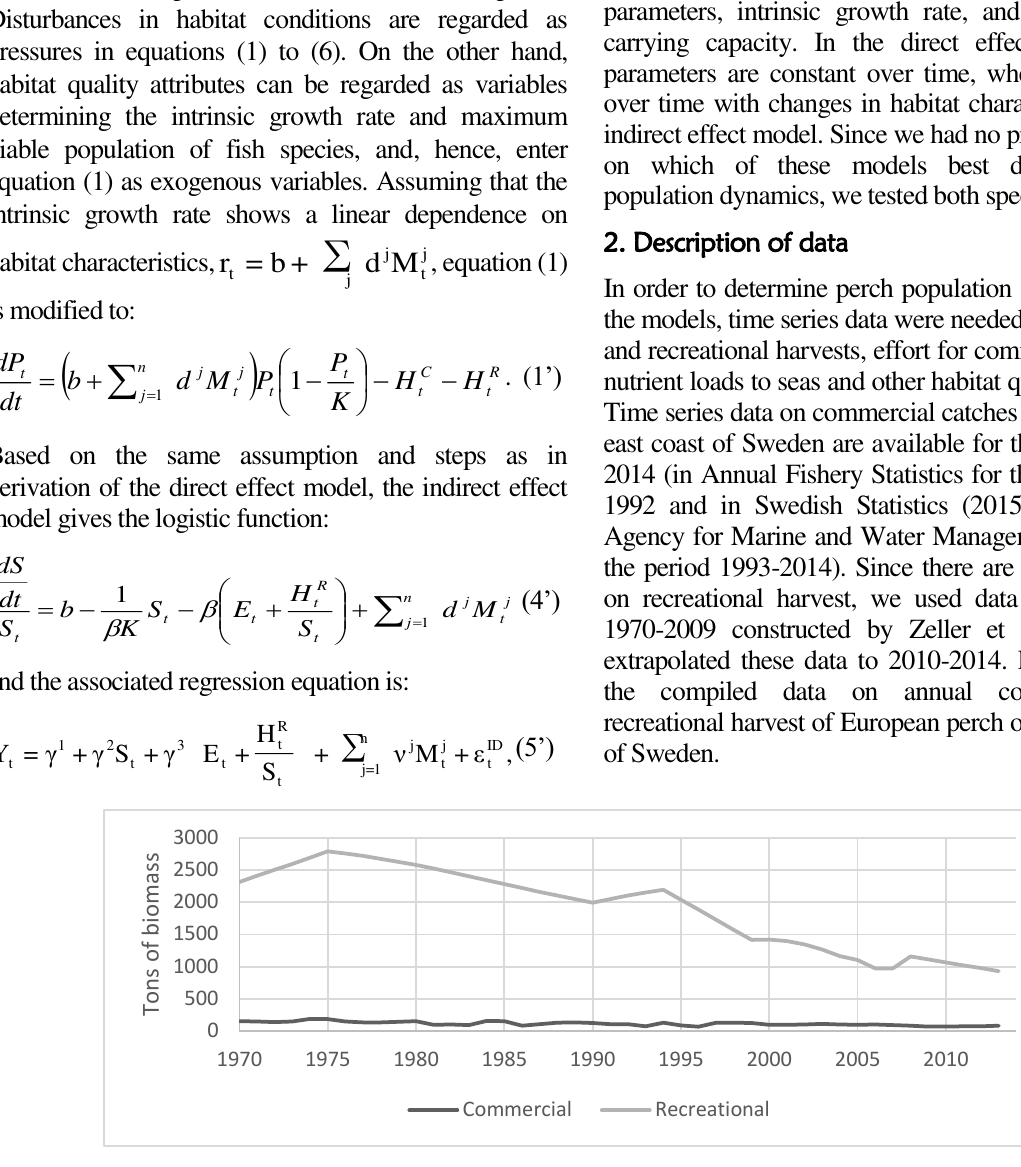
Fig. 1. Commercial and recreational harvest (tons) of perch off the east coast of Sweden, 1970-2014